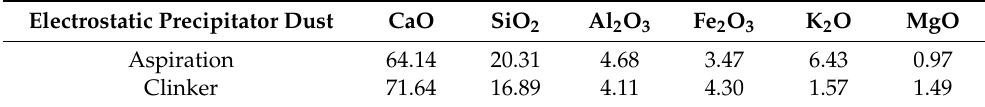
Table 2. Chemical composition of the dusts (wt. %).